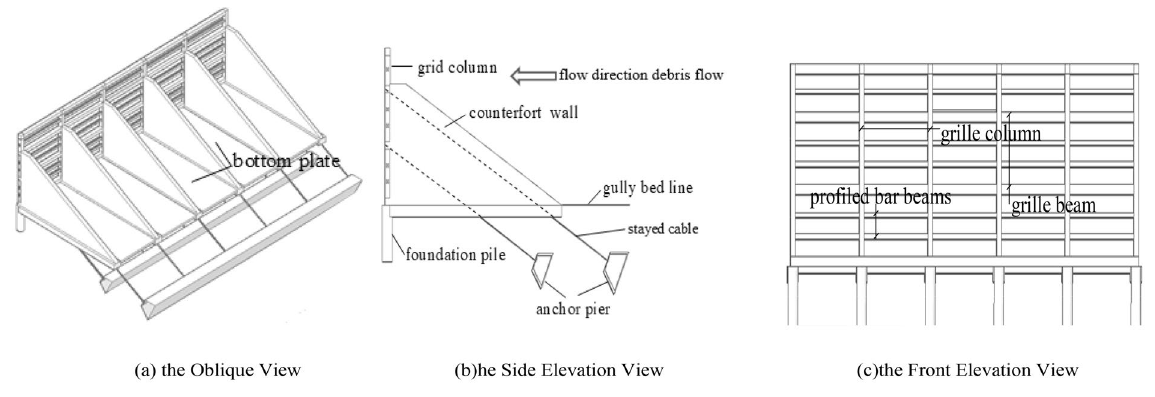
Figure 1. The structure for the